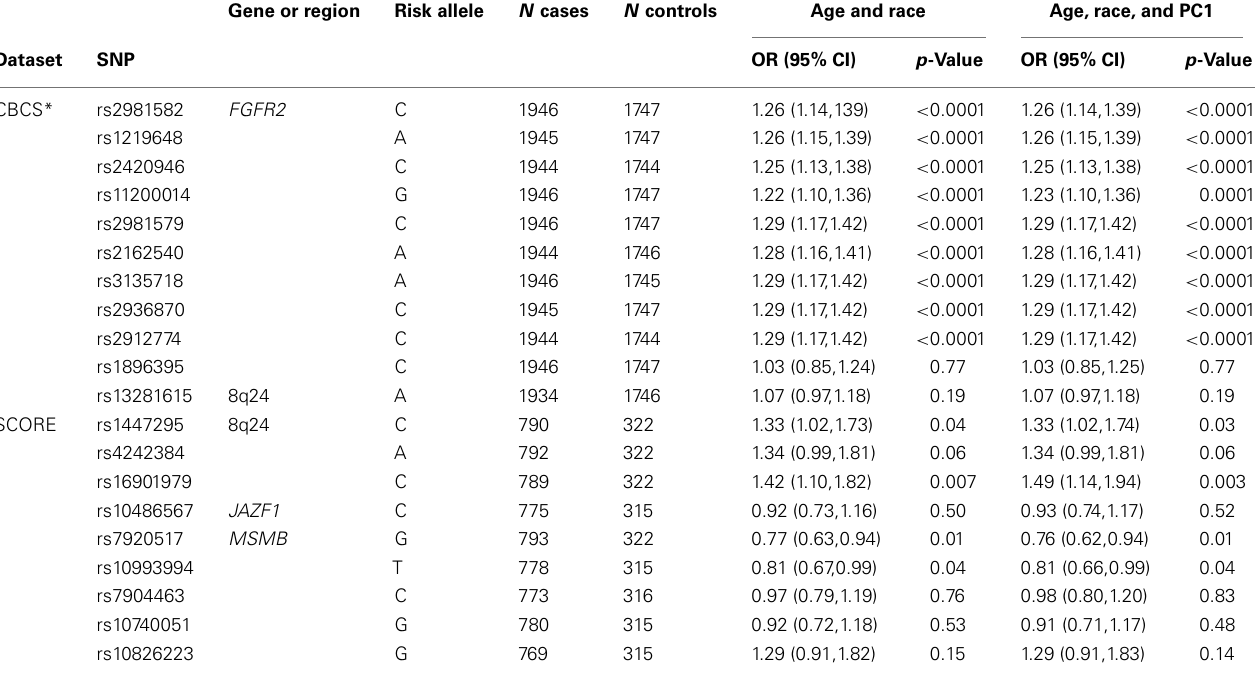
TableA1 | Assessment of population stratification adjustment on GWAS hit association results for CBCS and